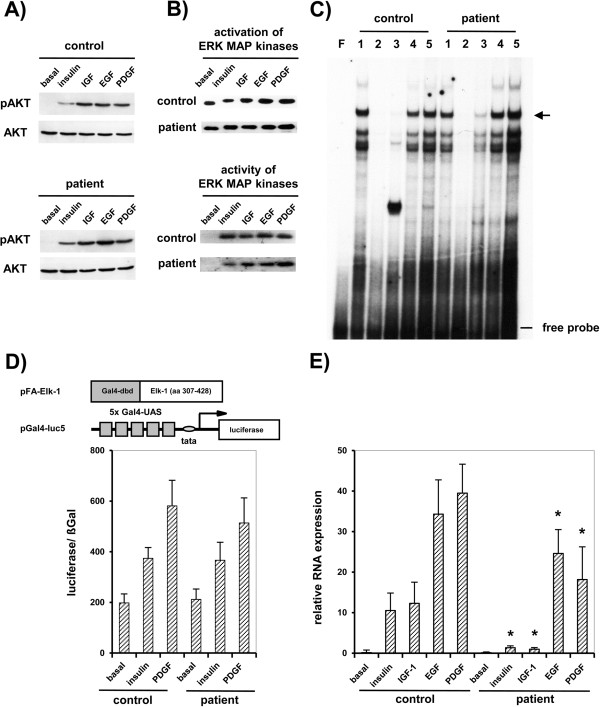
Localization of the postreceptor defect to c-fos expression. A) Western blot analyses of Akt phosphorylation and abundance. B) Phosphorylation of MAPK was assayed by western blot analyses. Activity of MAPK was detected in in-gel kinase assays. C) Formation of the ternary complex at sre element of c-fos promoter in control and patient. The specific complex is indicated by an arrow (lane F: free probe, 1: no competition; competition: 2: 100x SRE, 3: 10x SRE, 4: 100x SP-1, 5: 10x SP-1). D) Activation of ternary complex factor Elk-1 following insulin and PDGF stimulation in patient and control cells. Results are given as means (±S.D.). *p< 0.05 vs basal control. E) Transcriptional activation of c-fos mRNA. The mRNA levels were normalized against 18S rRNA as internal control. Values are means (±S.D.) from four independent experiments, each performed in triplicate. *p< 0.05 vs basal control.